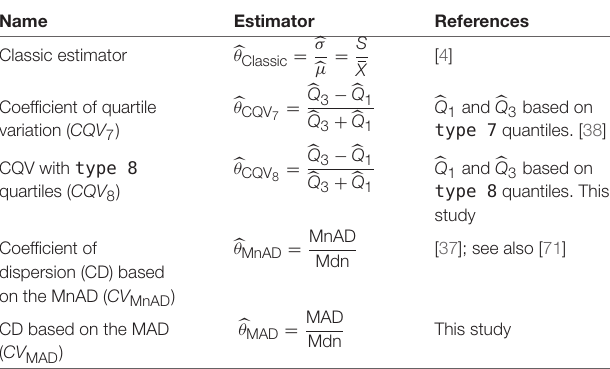
TABLE 1 | Estimators of relative variability considered in this